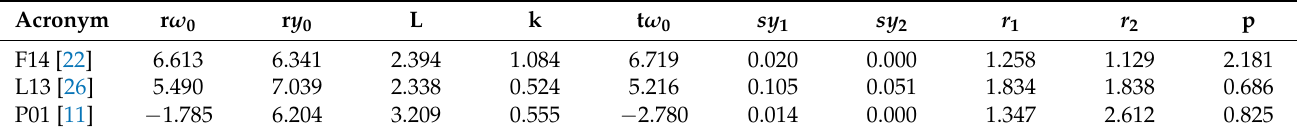
Table 2. Parameter values for the LBEM curves shown in Figure